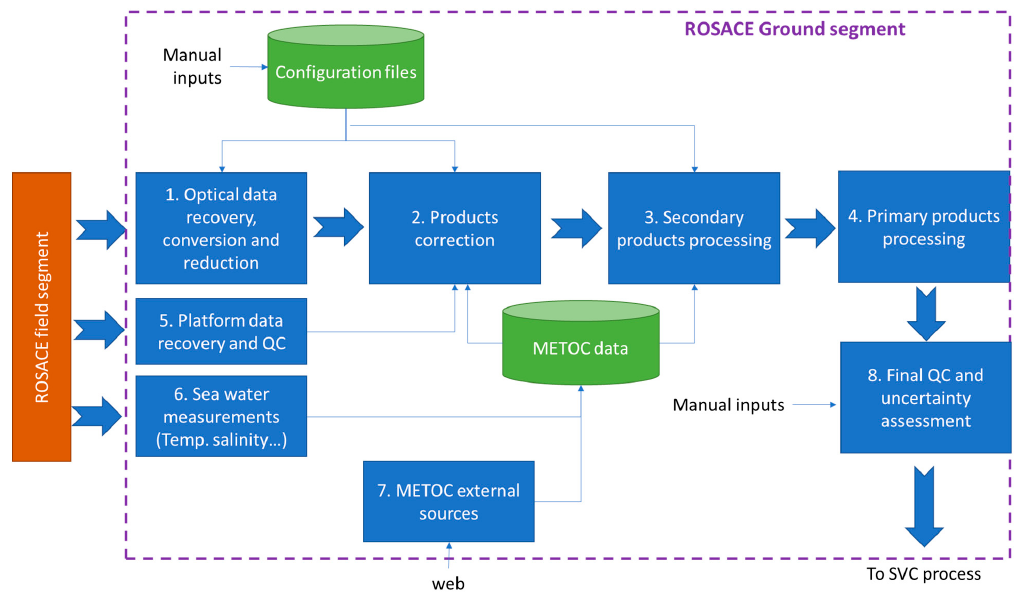
Figure 27. ROSACE data processing flow diagram.